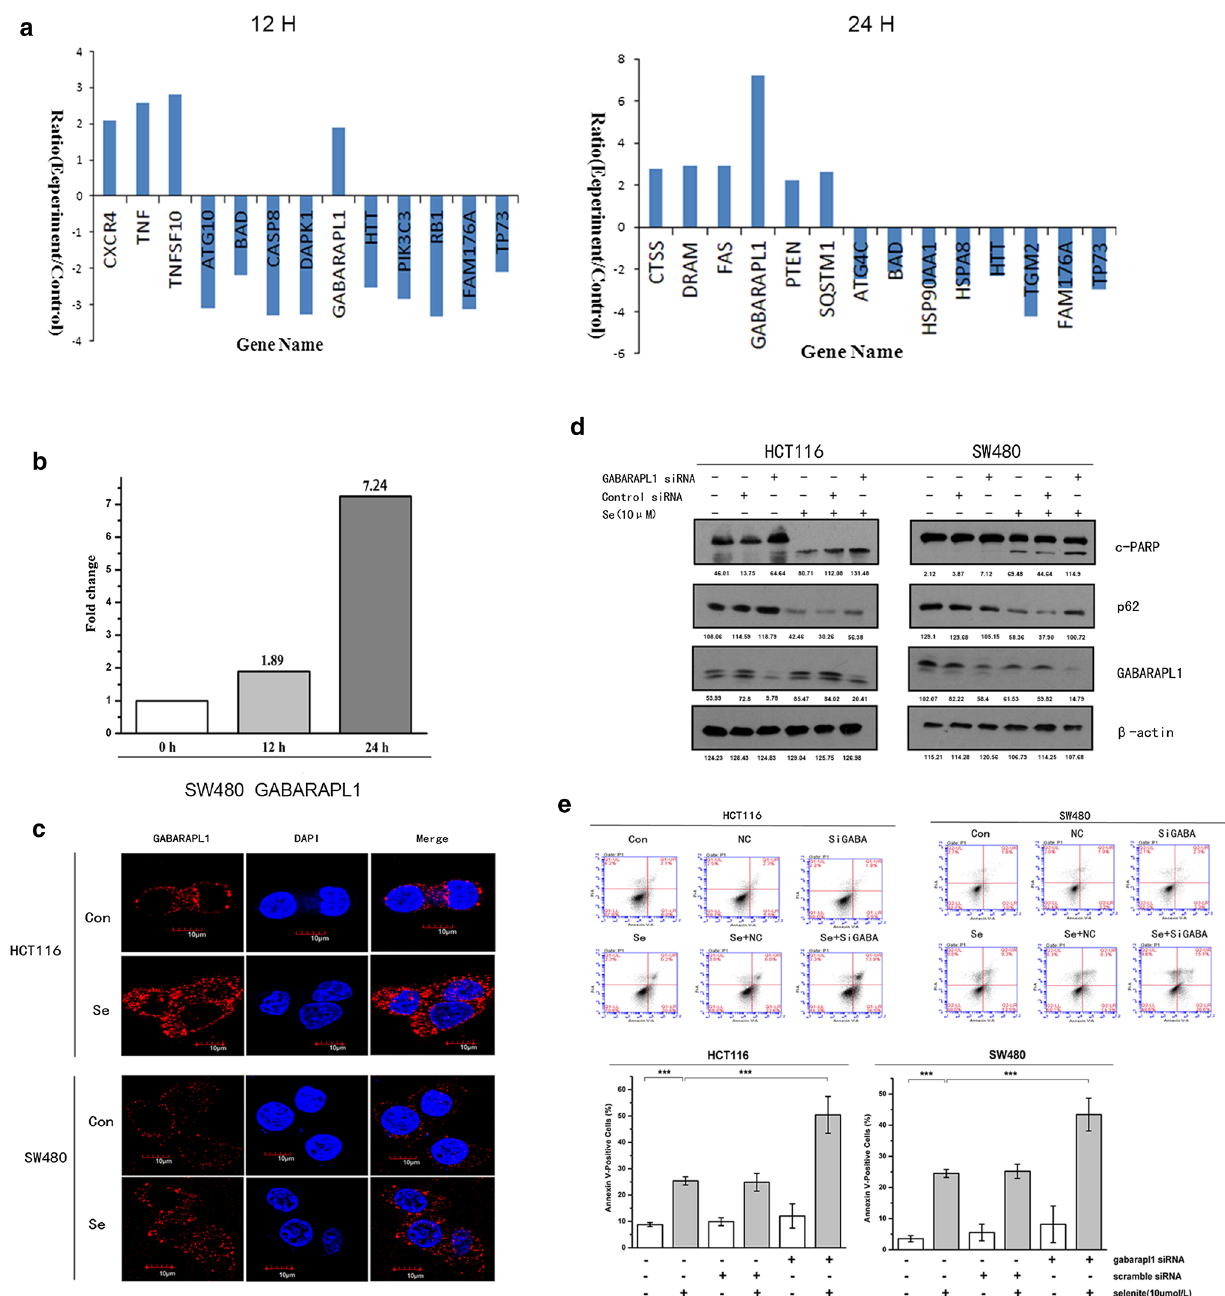
Fig. 1 GABARAPL-1 was upregulated by selenite treatment and was associated with autophagy and apoptosis of CRC cells. a Expression of genes markedly changed after selenite treatment in SW480 cells for 12 and 24 h were shown in the graph. b mRNA expression level of GABARAPL-1 after selenite treatment. c Confocal analysis of GABARAPL-1 protein level in selenite-treated SW480 and HCT116 CRC cells. The cells were incubated with primary antibody against GABARAPL-1 and Cy3-conjugated secondary antibody (red). The nuclei were stained with DAPI. Scale bar, 10 µm. d , e HCT116 and SW480 cells were treated with siRNA targeting GABARAPL-1 and subjected to western blot analysis or FACS analysis. The statistical graphs are presented as the mean ± S.D. of the three independent experiments, * p <